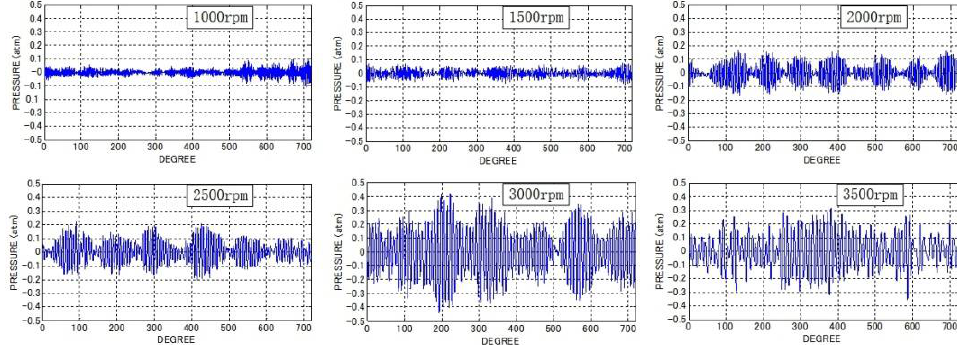
Figure 15. Frequency response curves of water jacket models with different impedance boundaries.